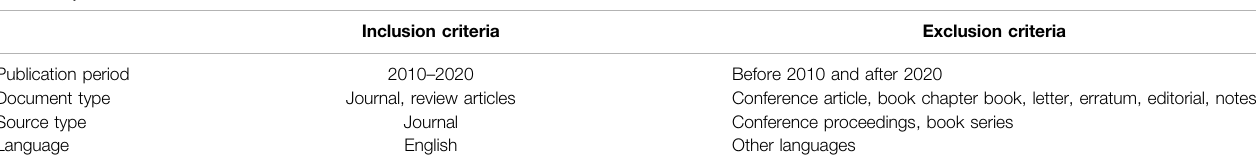
TABLE 3 | The inclusion and exclusion criteria for literature search.